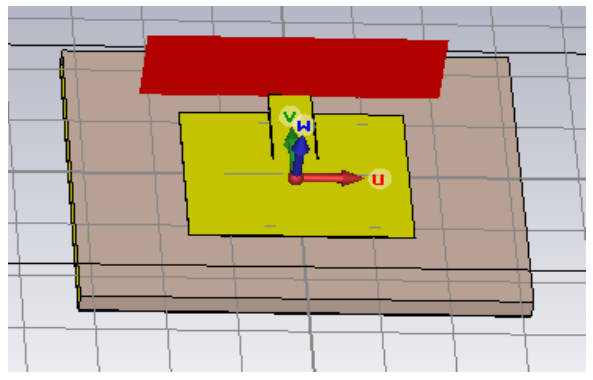
Figure 2. Designed Microstrip Patch Antenna for 5.8